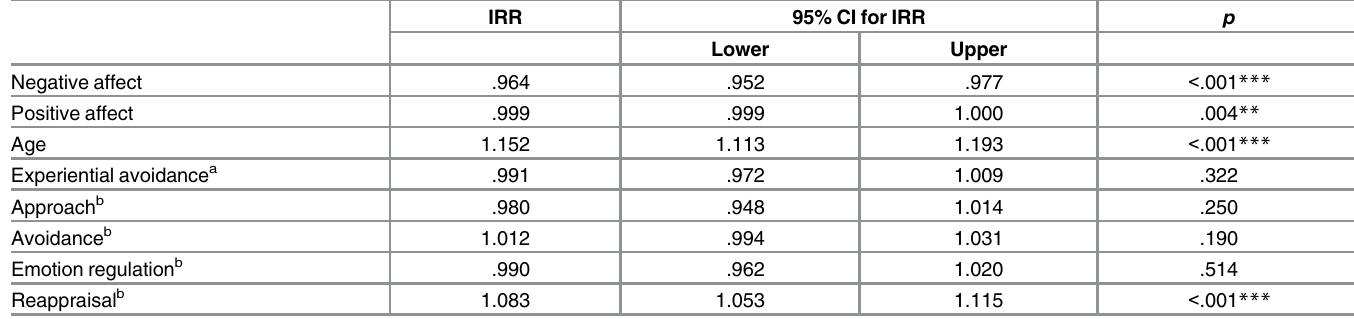
Table 6. Multivariate negative binomial regression exploring whether functional coping dynamics and experiential avoidance predict self-harm recency, when adjusting for age and affect ( n =